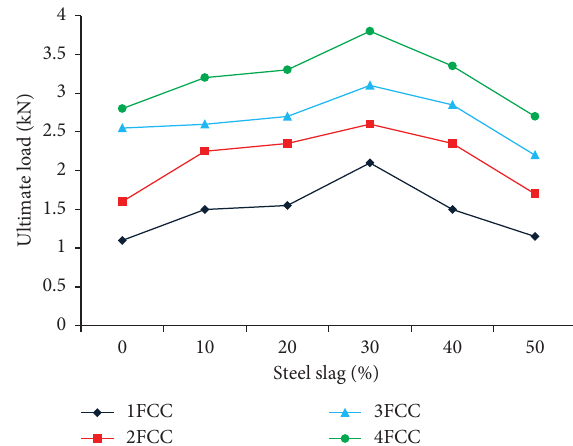
Figure 4: Ultimate load for different levels of steel slag replacement and volume fractions of chicken mesh ferrocement